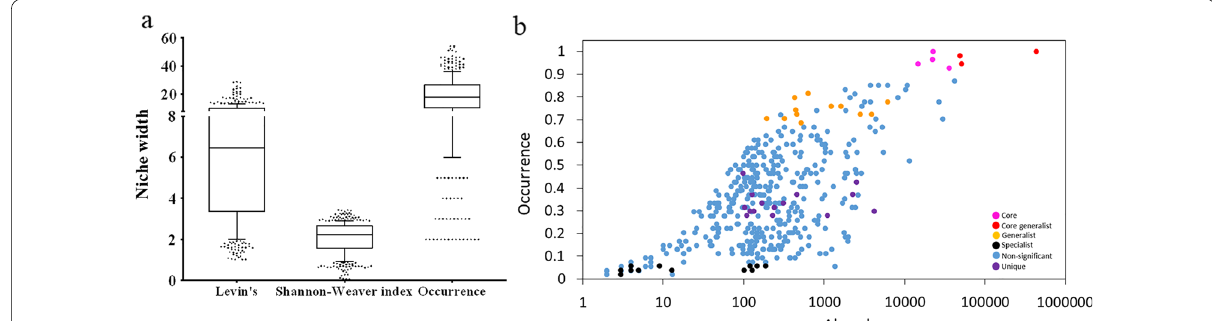
Fig. 3 a Niche breadth of microbes in sea urchin GMA following the different measured indices of Levin’s, Shannon–Weaver, and occurrence. Middle line in box plots represents mean value and whiskers are drawn from the 10th to 90th percentiles. Generalist or specialist microbes are shown at top or lowest decile, respectively (n 434). b Occurrence and cumulative abundance of each of the microbes in GMA indicates = differences of niche breadth and specialization in unique habitats. Each dot represents one microbe with a color indication indicating core, core‑generalist, generalist, specialist, unique, or not significant (n 434) =